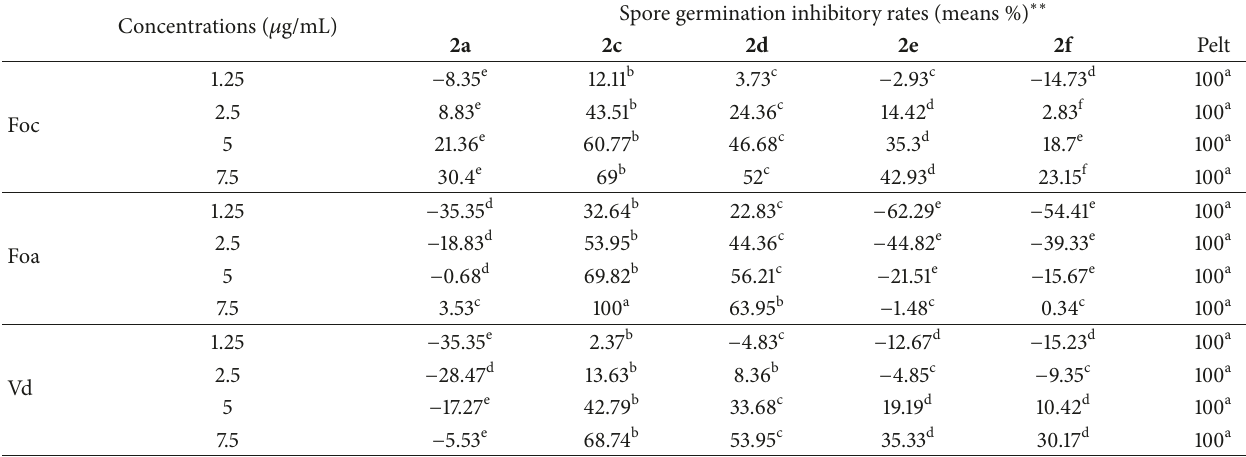
Table 3: Inhibition of the spore germination of Foc, Foa, and Vd under the effect of different concentrations of the polyorganochlorine derivatives ( 2a – f ) in comparison with the control, after 48 h of incubation at 28 ∘ C. Concentrations ( 𝜇 g/mL)